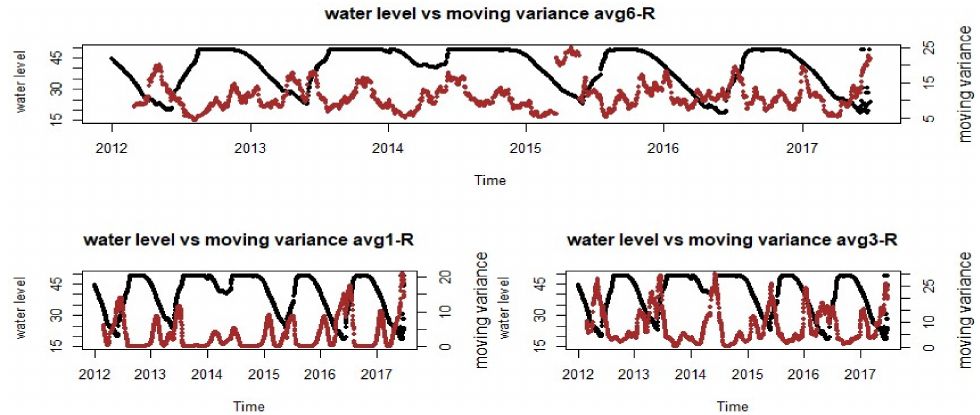
Figure 17. Avg6-R, avg1-R, and avg3-R 60-day moving variance ( ◦ C) (brown) against water level (m) (black).